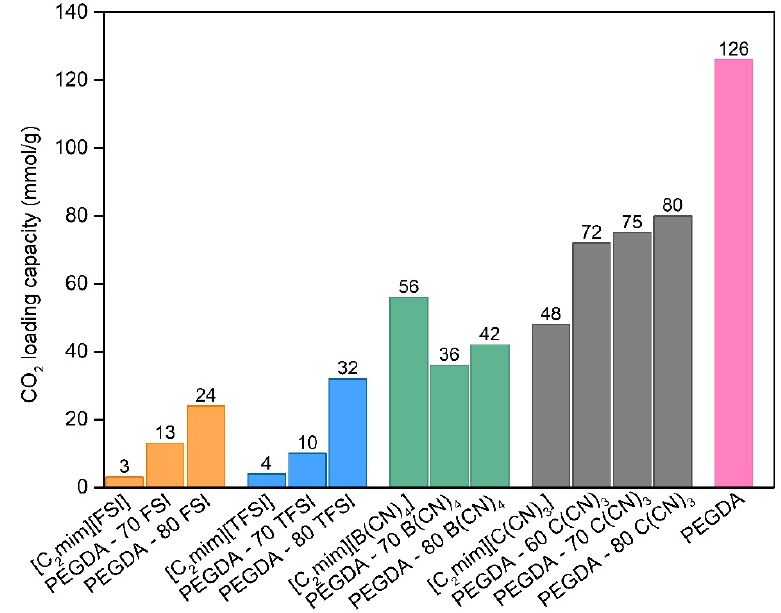
◦ C) for the neat ILs, cross-linked PEGDA and di ff erent Figure 7. CO 2 loading capacity (at 30 °C) for the neat ILs, cross-linked PEGDA and different iongels. Figure 7. CO 2 loading capacity (at 30